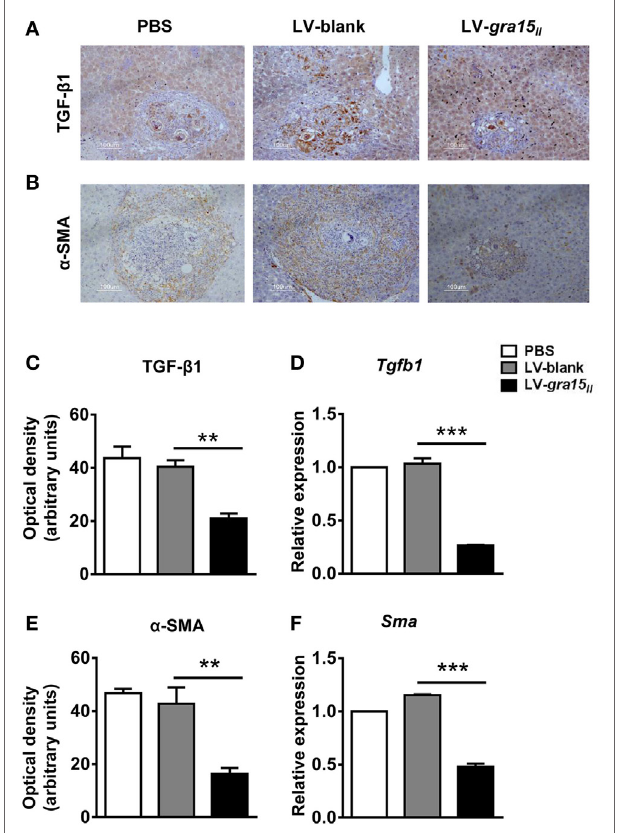
FigUre 5 | Lentiviral vector- gra15 II -M delivery decreased hepatic stellate cell (HSC) activation by the reduced expression of transforming growth factor-beta1 (TGF- β 1). TGF- β 1 protein level in liver was evaluated by IHC with quantitative analysis of optical density (a,c) ; the protein level of α -SMA in liver was evaluated by IHC with quantitative analysis of optical density (B,e) . Liver RNA was extracted and the expression of TGF- β 1 and α -SMA were analyzed by quantitative real-time PCR (D,F) . Data represent mean ± SD from multi-group experiments. ** p < 0.01 and *** p < 0.001 ( n = 4 each group).